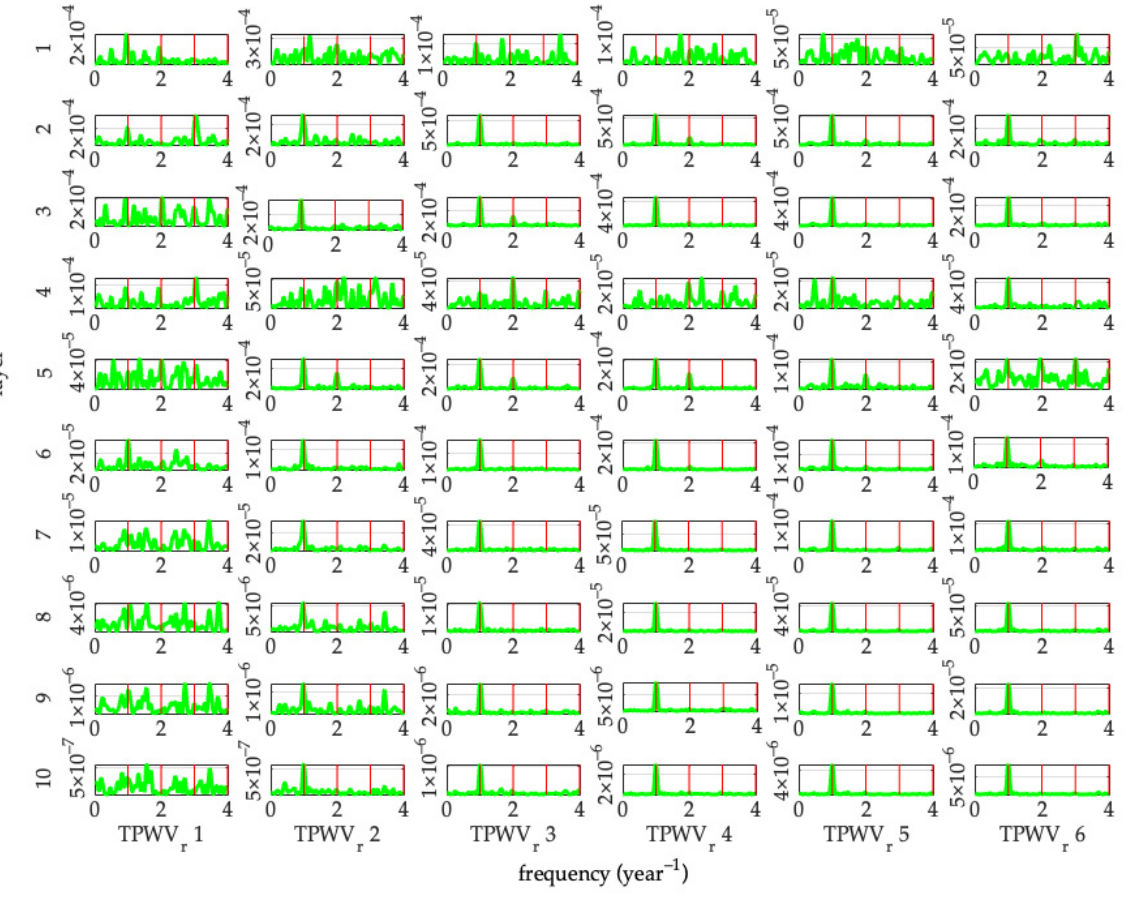
Figure 5. Power-period of 10-year IRPWV time series of the 10 layers within six TPWV r at KOWLOON station. The x -axis is the frequency (year − 1 ) of the time-series, and the magenta lines 1, 2, 3, and 4 are the marks of annual, semi-annual, 4-month, and seasonal cycles, respectively. The peak of the green curve represents the degree of frequency. The power-periodic figures of the remaining 11 stations are shown in the Supplementary Materials.